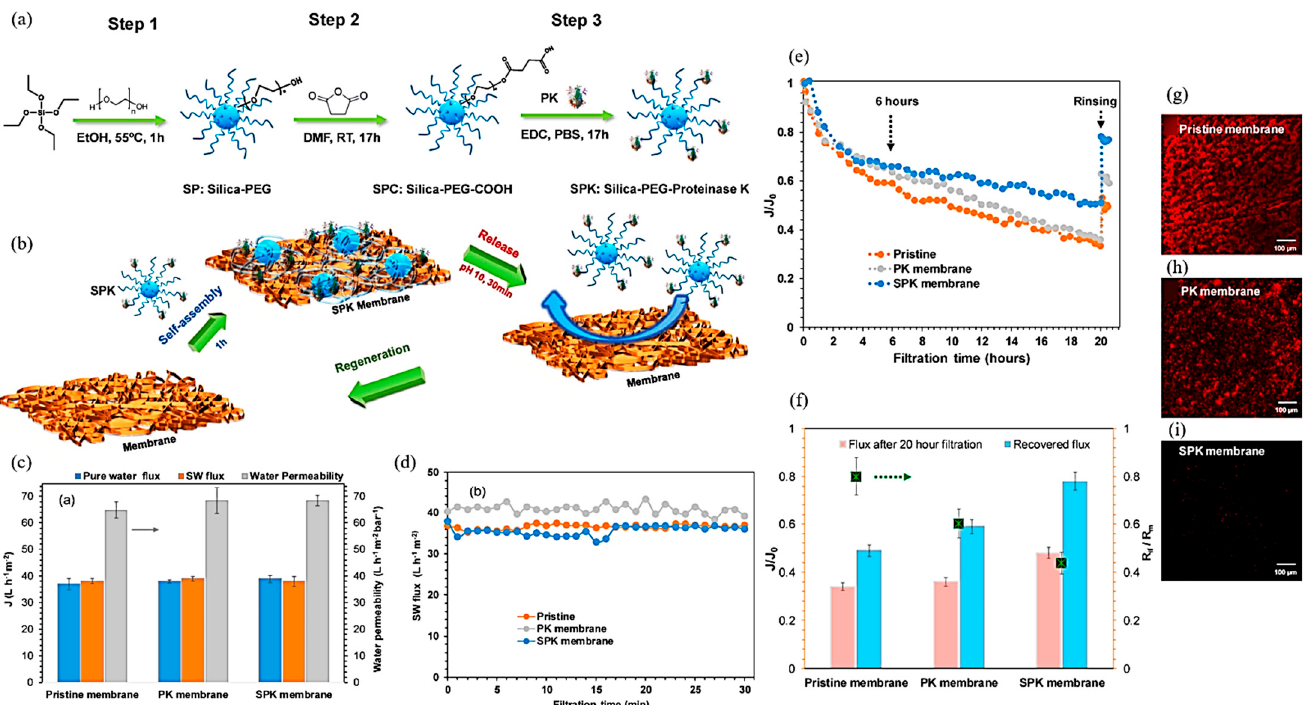
Figure 4. ( a ) Schematic diagram of the synthesis of SPK nanoparticles. ( b ) Schematic representation of the self-assembly and regeneration of SPK membrane. ( c ) Water permeability of the pristine, PK, and SPK membranes and their permeate fluxes for filtration of the pure water and municipal wastewater (absence of bacteria). ( d ) Fluxes over time of the pristine, PK, and SPK membranes during filtration of the municipal wastewater under ∆ p = 0.5 bar. Pristine, PK, and SPK membranes’ filtration of P. fluorescens bacterial suspension (~10 7 cell/mL) in municipal wastewater matrix. ( e ) Variation of filtration flux over time. ( f ) The operating fluxes after 20 h filtration, recovered fluxes after rinsing, and relative irreversible fouling resistance after filtration. ( g – i ) Fluorescence images of membranes after the filtration process, P. fluorescens (red) [87]. (Copyright (2021) with permission from Elsevier Ltd.).